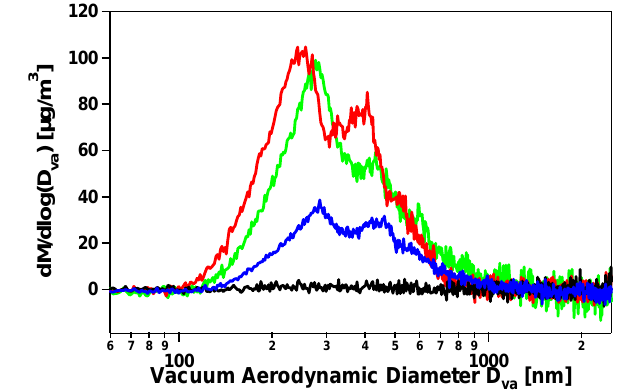
Fig. 5. Mass size distributions derived from the CO + the pToF mode of the Q-AMS. Blue: aerosol before annealing , Figure 5. Mass size distributions derived from the CO 2+ signal in the pToF mode of the Q- AMS vaporizer at 300 ◦ C (case 1), black: aerosol after annealing at AMS. Blue: aerosol before annealing , AMS vaporizer at 300 °C (case 1), black: aerosol after 300 ◦ C, Q-AMS vaporizer at 300 ◦ C (case 2), green: aerosol before annealing at 300 °C, Q-AMS vaporizer at 300 °C (case 2), green: aerosol before annealing , annealing , Q-AMS vaporizer 900 ◦ C (case 3), , red: aerosol after Q-AMS vaporizer 900 °C (case 3), , red: aerosol after annealing at 300 °C, Q-AMS vaporizer annealing at 300 ◦ C, Q-AMS vaporizer 900 ◦ C (case 4). 900°C (case 4).